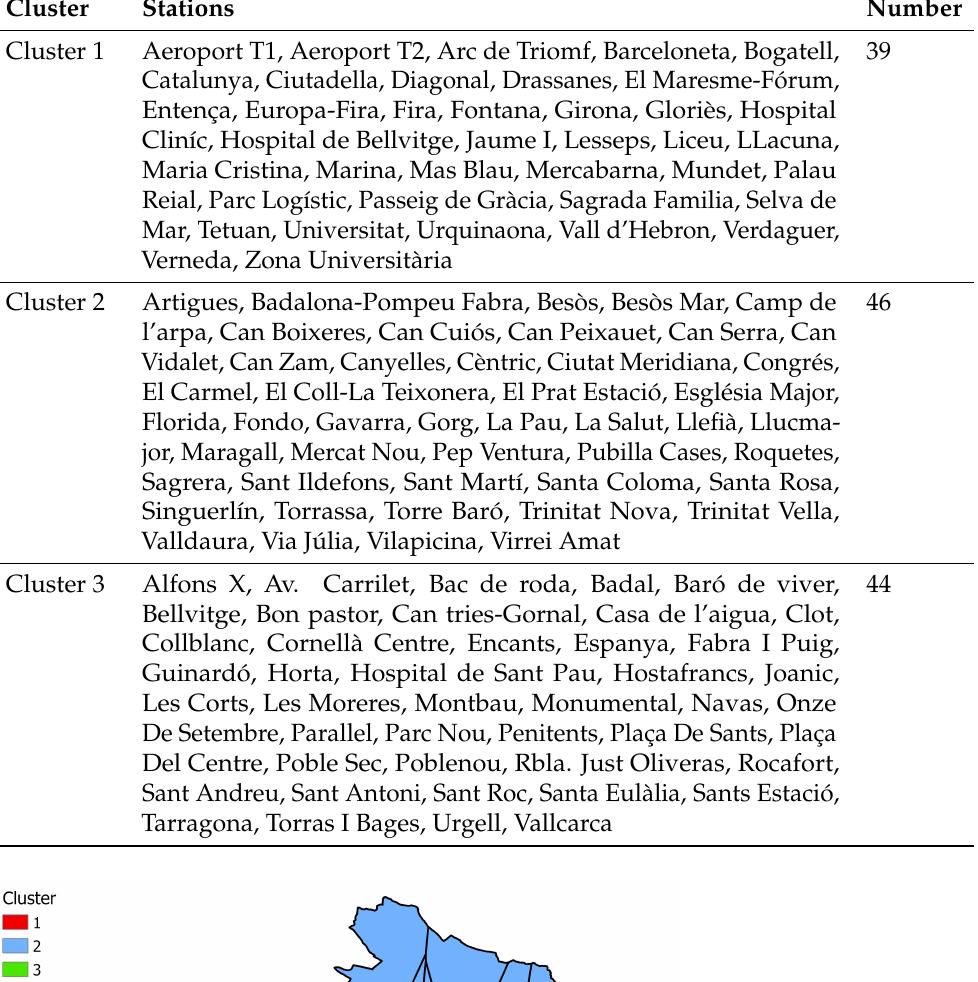
Table 7. Results of station classification.